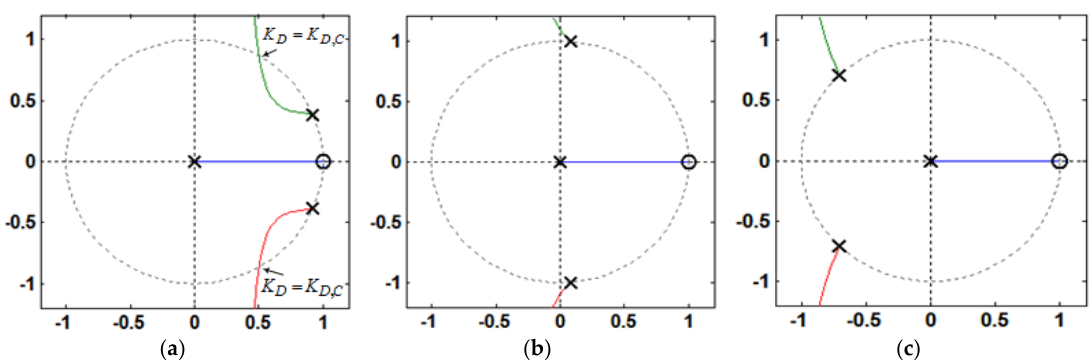
Figure 11. Root loci of the inner proportional CCF only (open-loop characteristic equation): ( a ) f res < f s /6; C f = 36 μ F; ( b ) f s /6 < f res < f s /3; C f = 2.5 μ F; and ( c ) f s /3 < f res < f s /2; C f = 1 μ F.